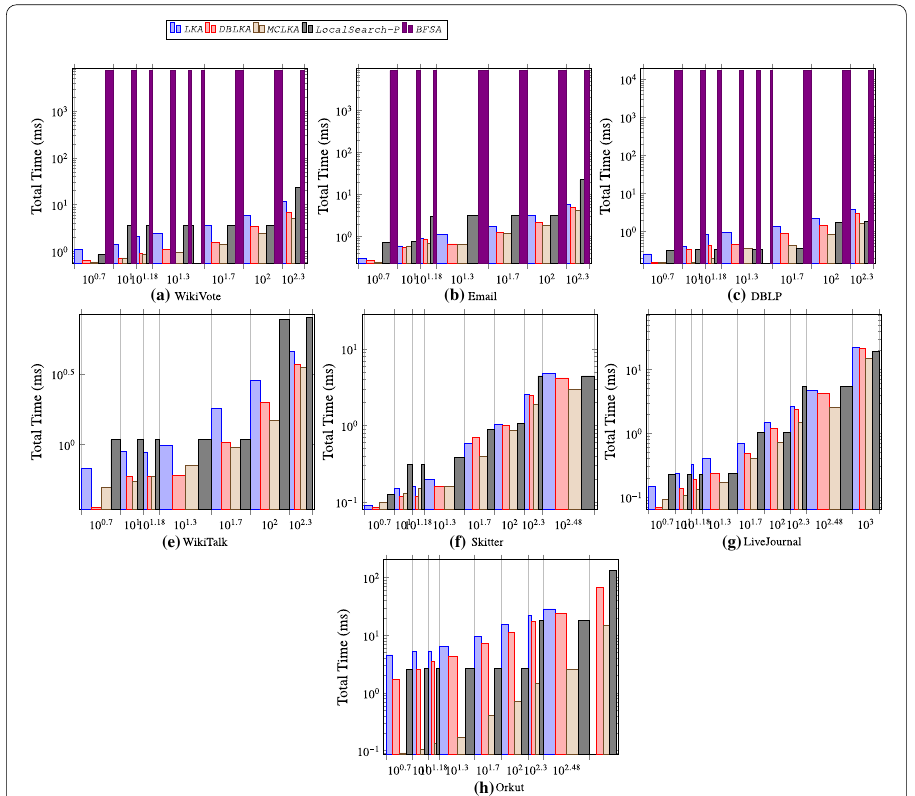
Fig. 7 Execution time of the proposed algorithms against BFS and LocalSearch‑P Algorithms while k and r is